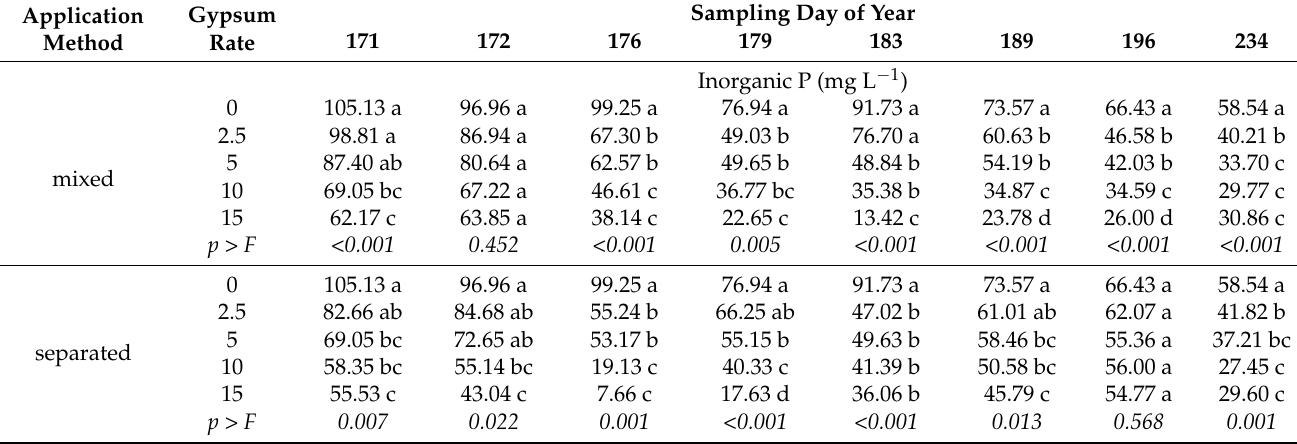
Table 2. Temporal changes in dissolved P concentration leaching losses observed over time from containers in 2019 as affected by FGD gypsum mixed with medium or placed at the bottom of containers fertilized with a controlled-released